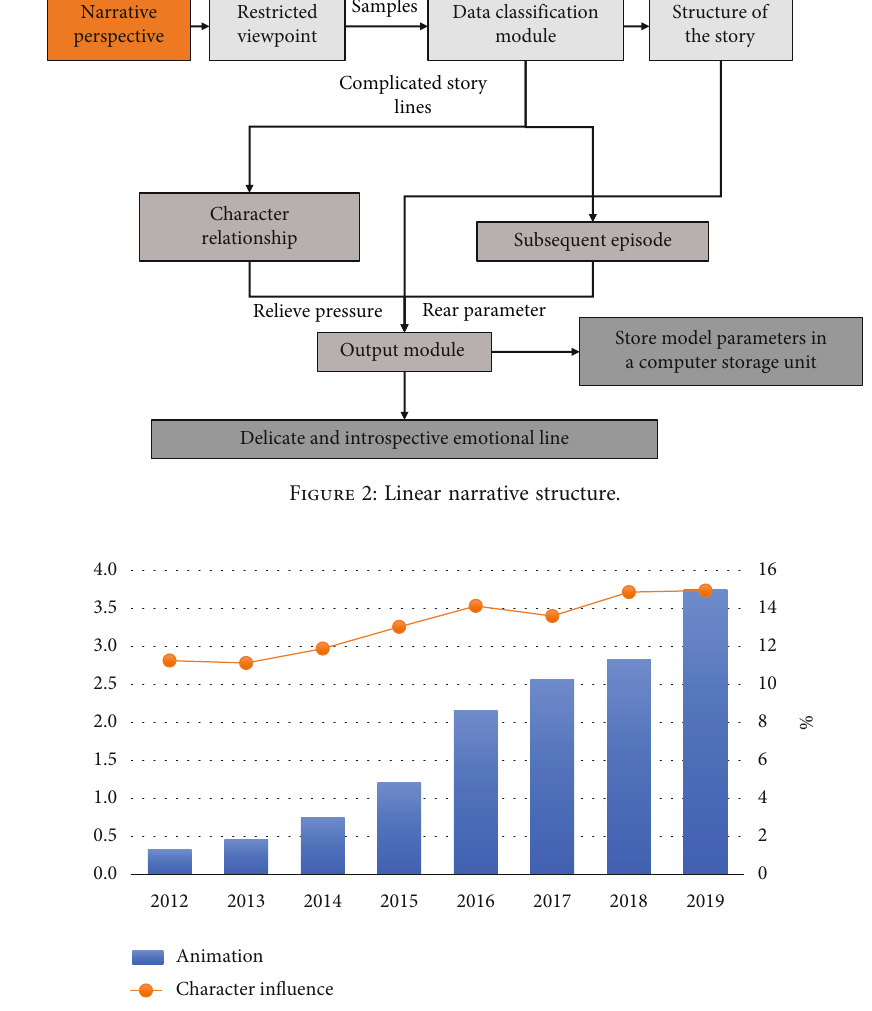
Figure 3: Emotional link between character in fl uence and